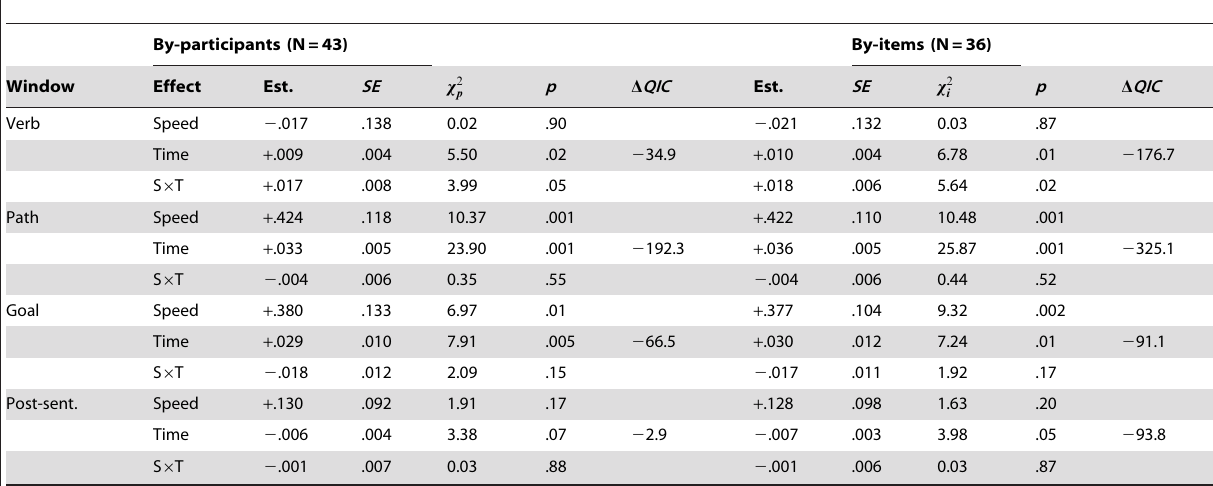
Table shows GEE modelling results for occurrences of looks to the Goal ROI as a function of Verb Speed (fast vs. slow) and Time (continuous predictor referring to the 50 ms time-bins per window). Shown are the by-participant/by-item GEE parameter estimates and corresponding SE s (both in logit units) along with generalised score chi square statistics and related p -values (at df =1). As for interactions (S 6 T), a positive parameter estimate indicates a more positive slope for the Time predictor in the fast than in the slow Verb Speed condition. D QIC refers to the goodness of fit of the Verb Speed 6 Time model in relation to a competitor Agent-Verb Suitability 6 Lexical Frequency 6 Time model (negative D QICs indicate superior fit of the Verb Speed 6 Time model).